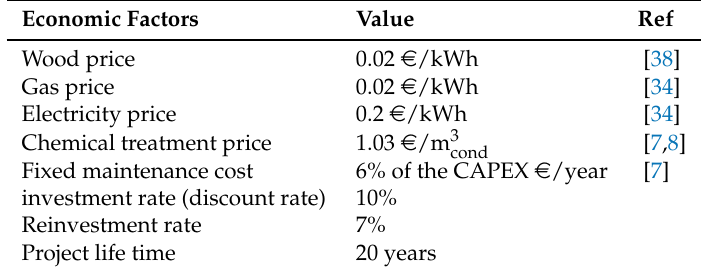
Table 3. Economic factors assumed in the representative DH plant case